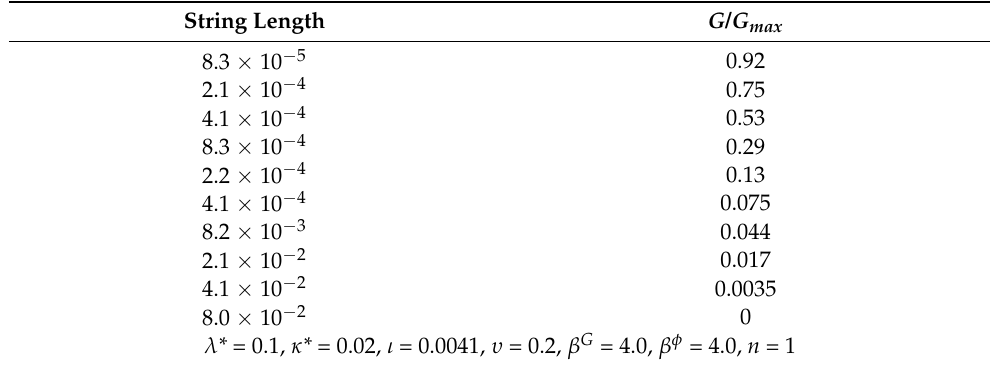
Table 1. BRICK soil model input parameters for the modelling of London clay (after Simpson,